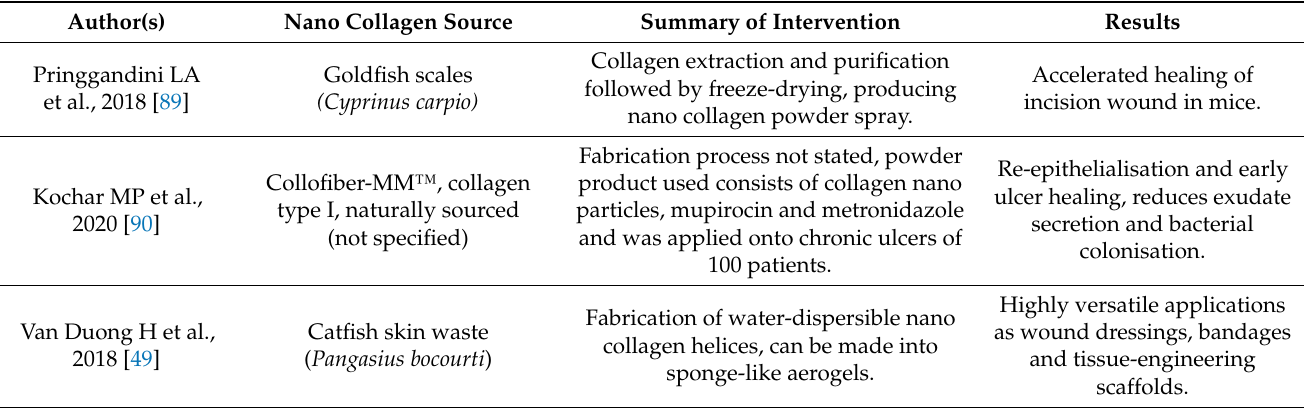
Table 2. Description of other studies that have been conducted on nano collagen fabrication, intervention and its potential use on skin